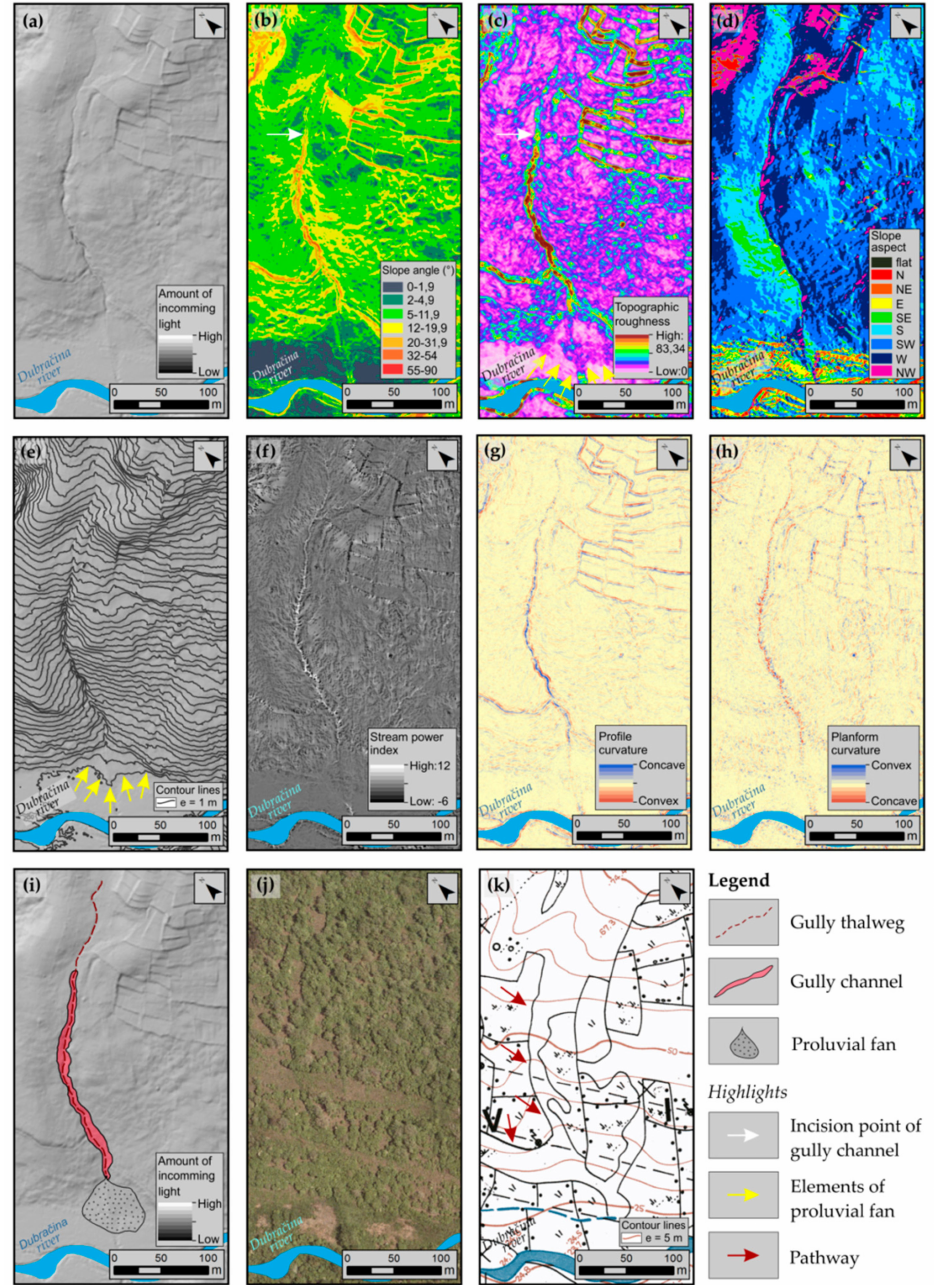
Figure 7. Visualization of topography of a linear and narrow gully on HR LiDAR imagery: ( a ) the semi-transparent (50%) hillshade map 45 ◦ / 30 ◦ over the hillshade map 315 ◦ / 45 ◦ ; ( b ) the slope map; ( c ) the topographic roughness map; ( d ) the aspect map; ( e ) the contour line map over the hillshade map; ( f ) the stream power index map; ( g ) the profile curvature map; and ( h ) the planform curvature map. ( i ) The hillshade map with a delineated polygon representing the gully channel and a line representing the gully thalweg. A small proluvial fan was identified at the mouth of the gully channel. ( j ) The DOM 1:5000 and ( k ) the CBM 1:5000 of the interpreted